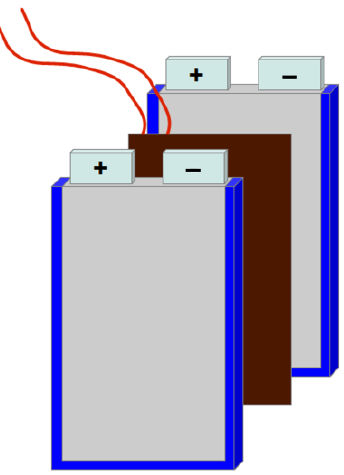
Figure 5. Sandwich setup used inside the EV ARC for the heat capacity determination. A heater foil is placed between two pouch cells.